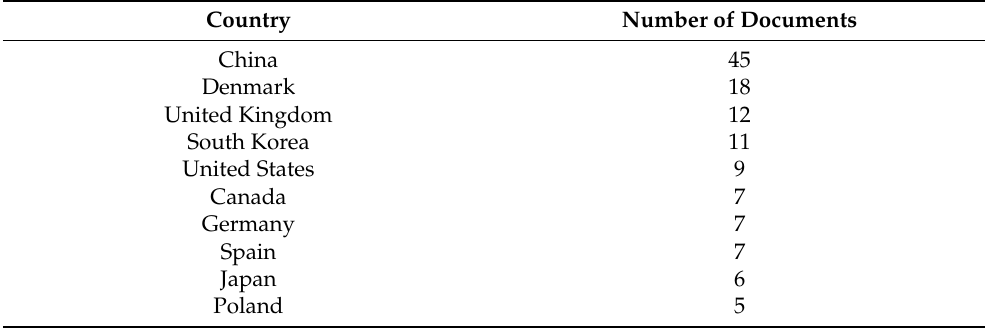
Table 2. Top ten countries that have published the most on the topic in the Energies journal.